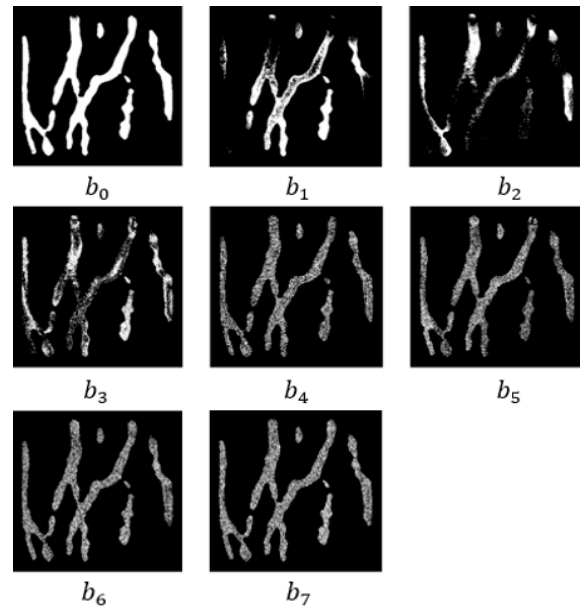
Figure 8. Eight ‐ bit planes. Figure 8. Eight-bit